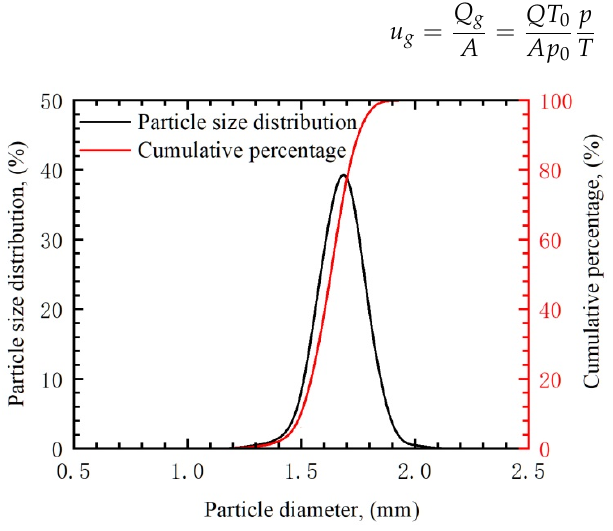
Figure 2. Particle size distribution and cumulative percentage.